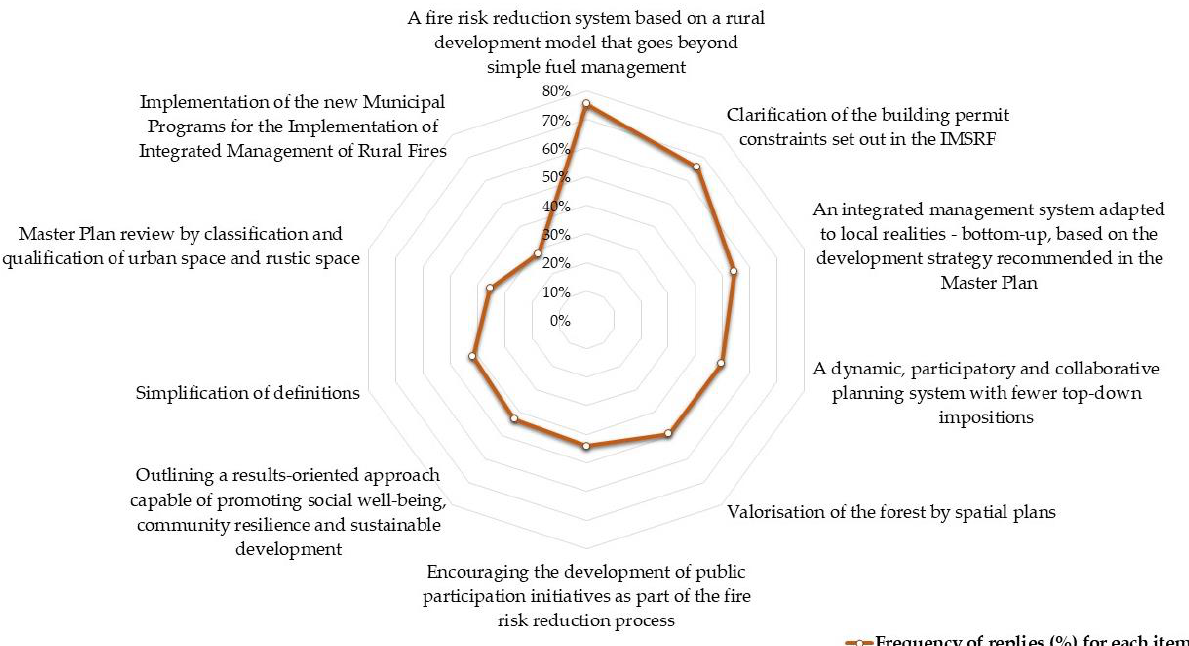
Figure 5. Considered importance for each suggestion to improve the alignment between the instru- ments of spatial planning and the wildfire management.